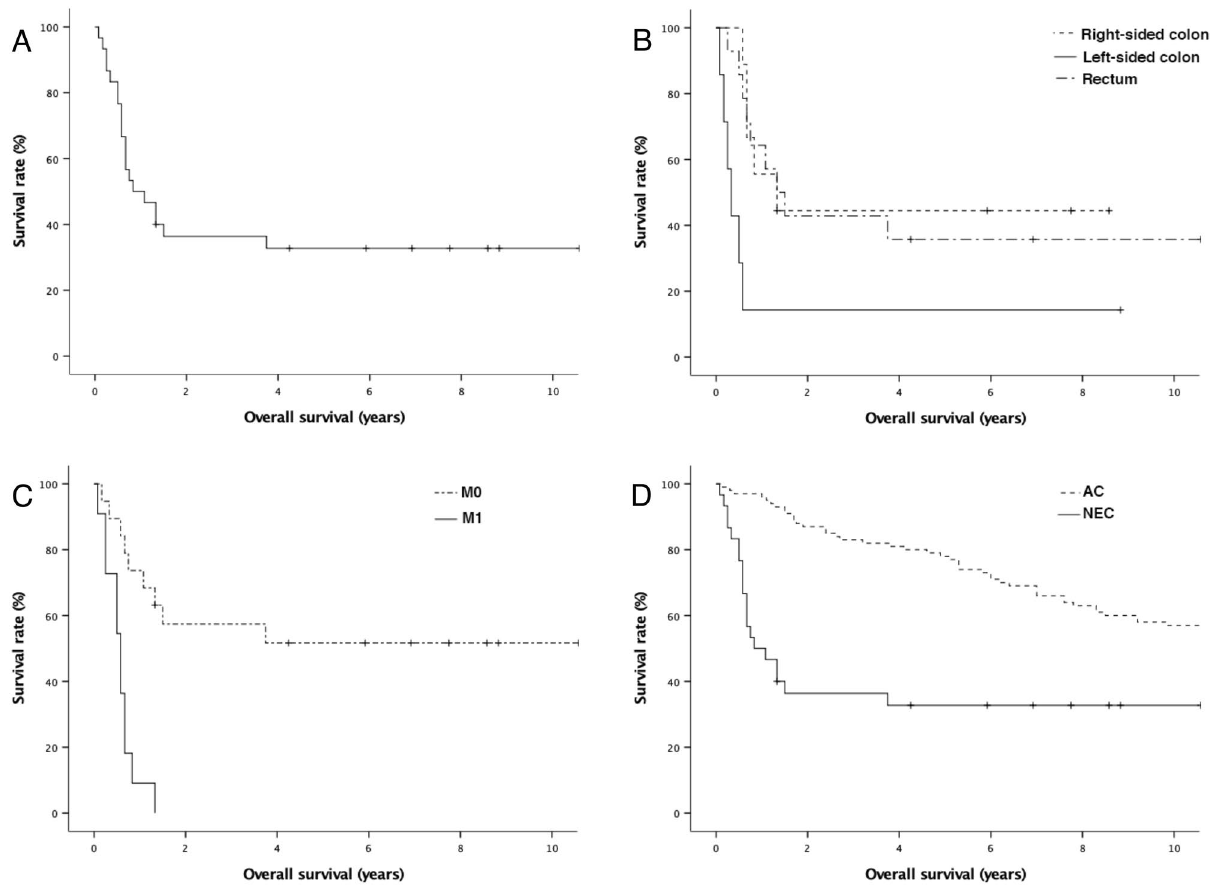
Figure 4. Kaplan–Meier cumulative survival curves. ( A ) Overall survival. ( B , C,D ) Survivals according to the tumour sites; right-sided colon vs. left-sided colon vs. rectum ( p = 0.013); M0 vs. M1 ( p < 0.001); AC vs. NEC ( p < 0.001).